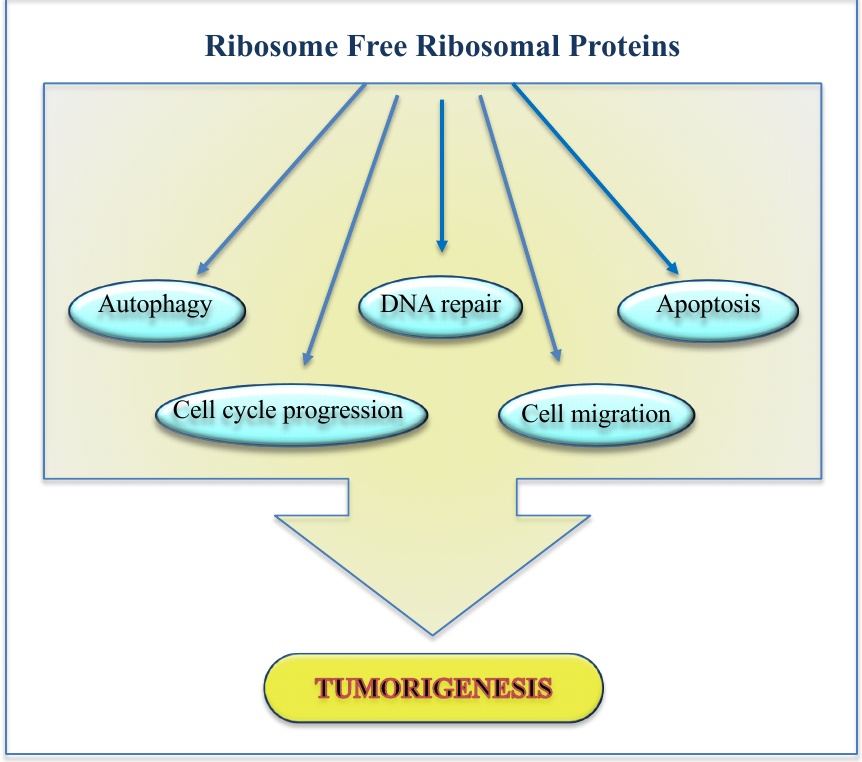
Figure 2. Role of ribosome free RPs in